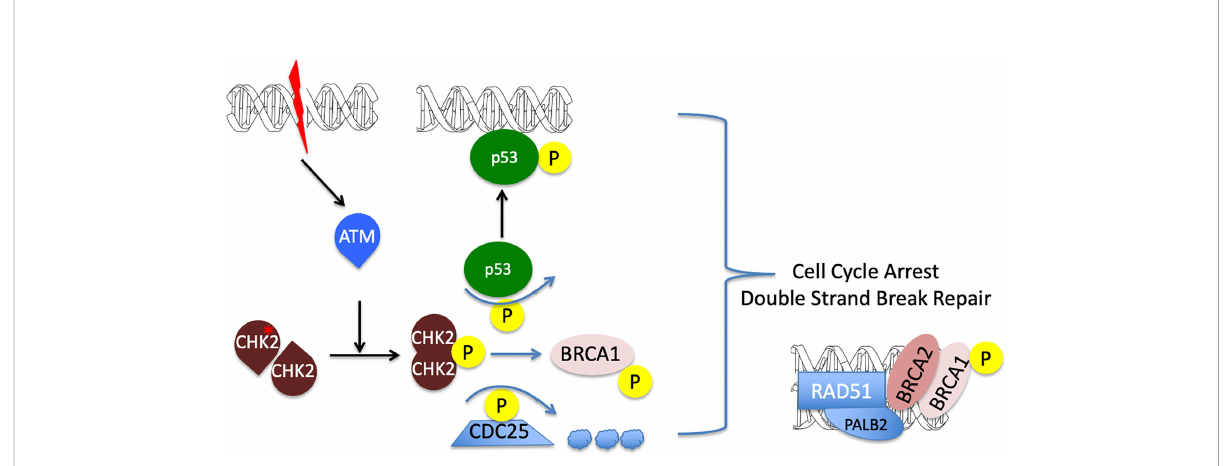
FIGURE 4 A diagram illustrating CHEK2 function in cell cycle arrest and DNA repair. Double strand break in the DNA leads to ATM activation and subsequent CHEK2 phosphorylation and dimerization. Activated CHECK2 in turn mobilizes p53 and BRCA1 and promotes degradation of the CDC25 phosphatase. The resulting formation of active p53 and RAD51/PALB2/BRCA1/2 DNA complexes, together with a down-regulation of CDC25, leads to the initiation of double strand break repair and cell cycle arrest. Decrease in CHEK2 kinase activity results in the loss of cell cycle control and promotes genomic instability (reviewed in